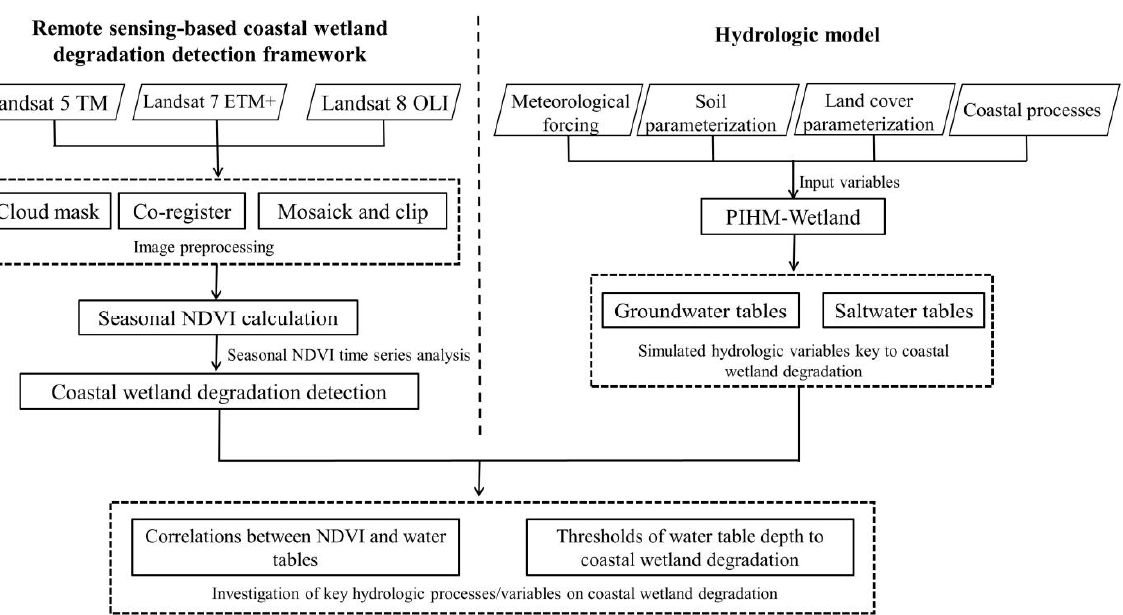
Figure 2. The workflow of this study.